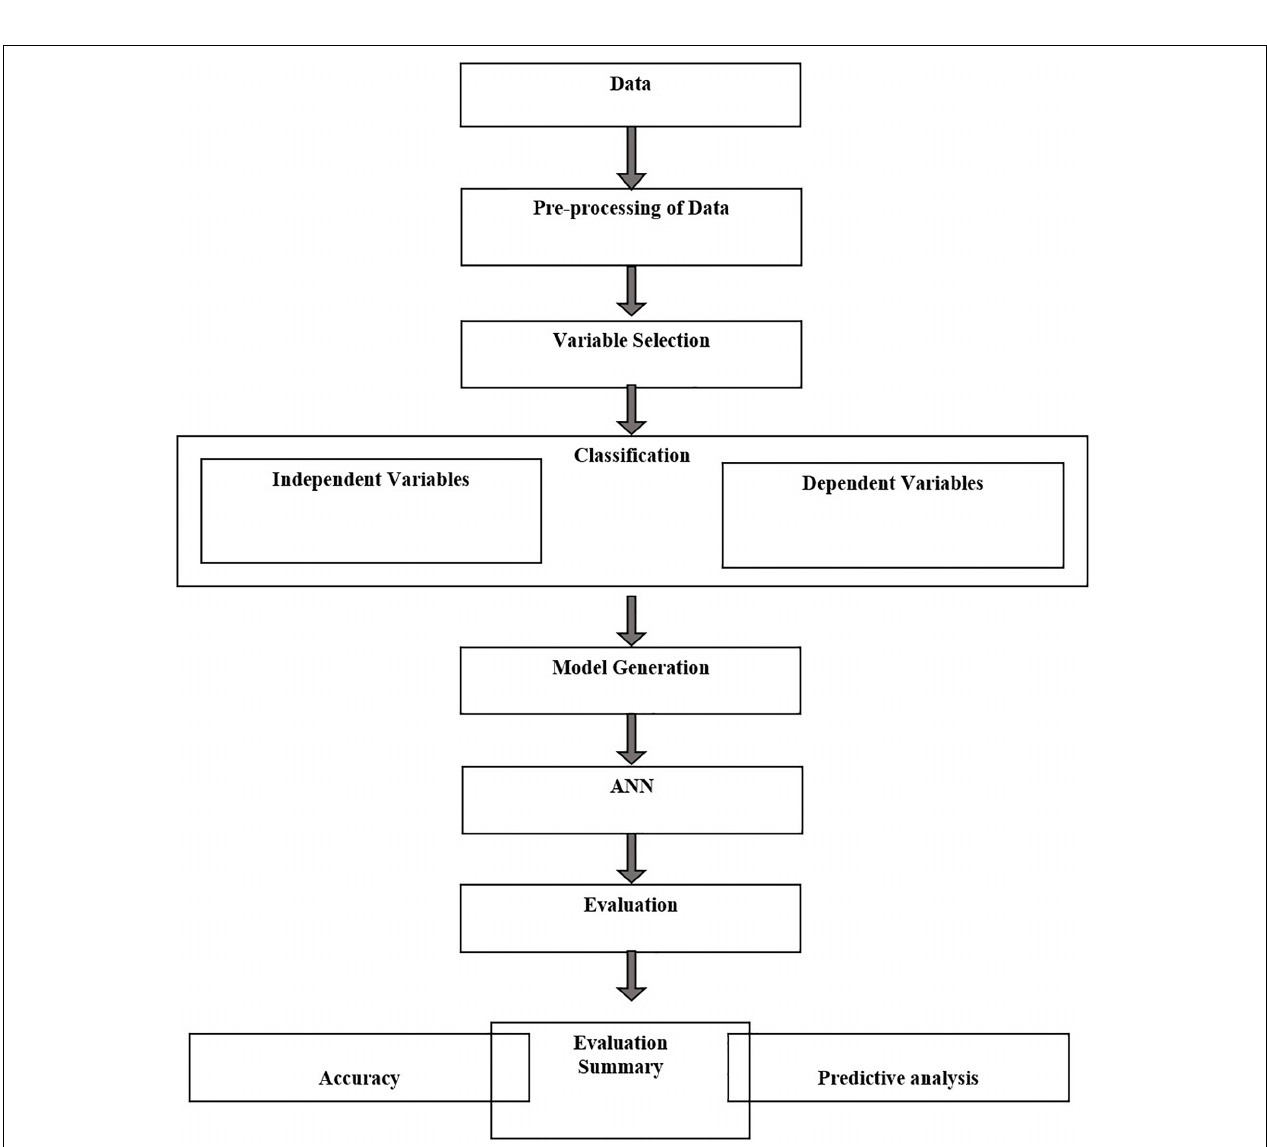
FIGURE 2 | Flow chart of ANN methodology for data processing, normalization, training, testing, and prediction.